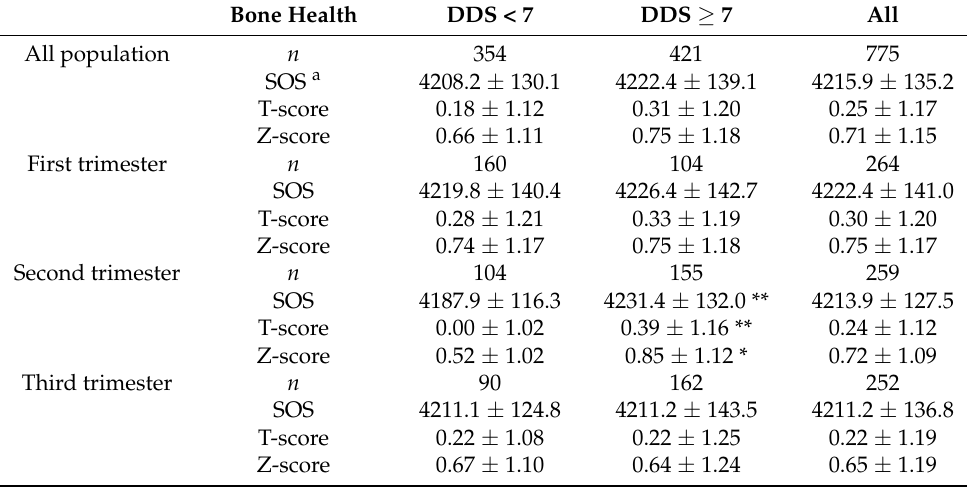
Table 4. Bone status according to the dietary diversity score (DDS) in the different trimesters. Bone Health